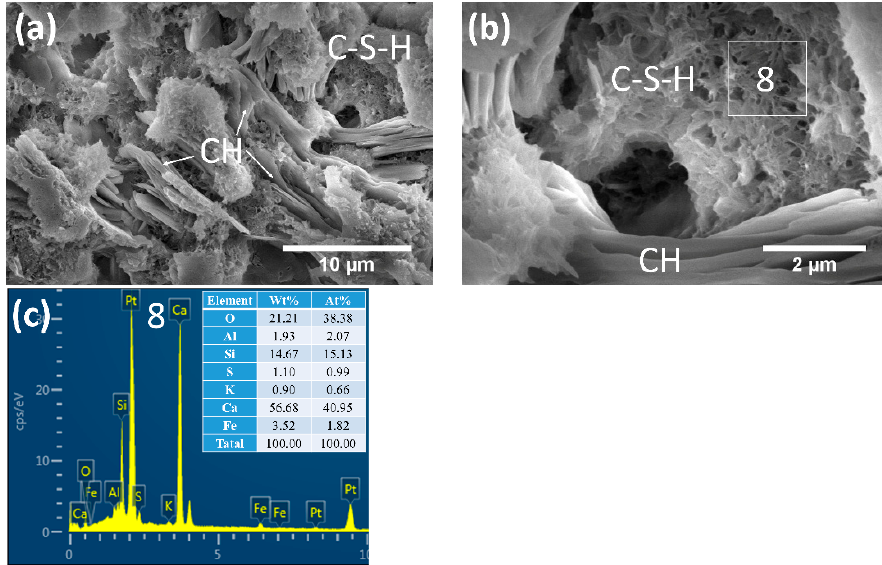
Figure 9. SEM images of pure cement paste after standard curing for 28 d, ( a ) reticular C-S-H gels and CH; ( b ) reticular C-S-H gels and CH; ( c ) EDS result of area 8.